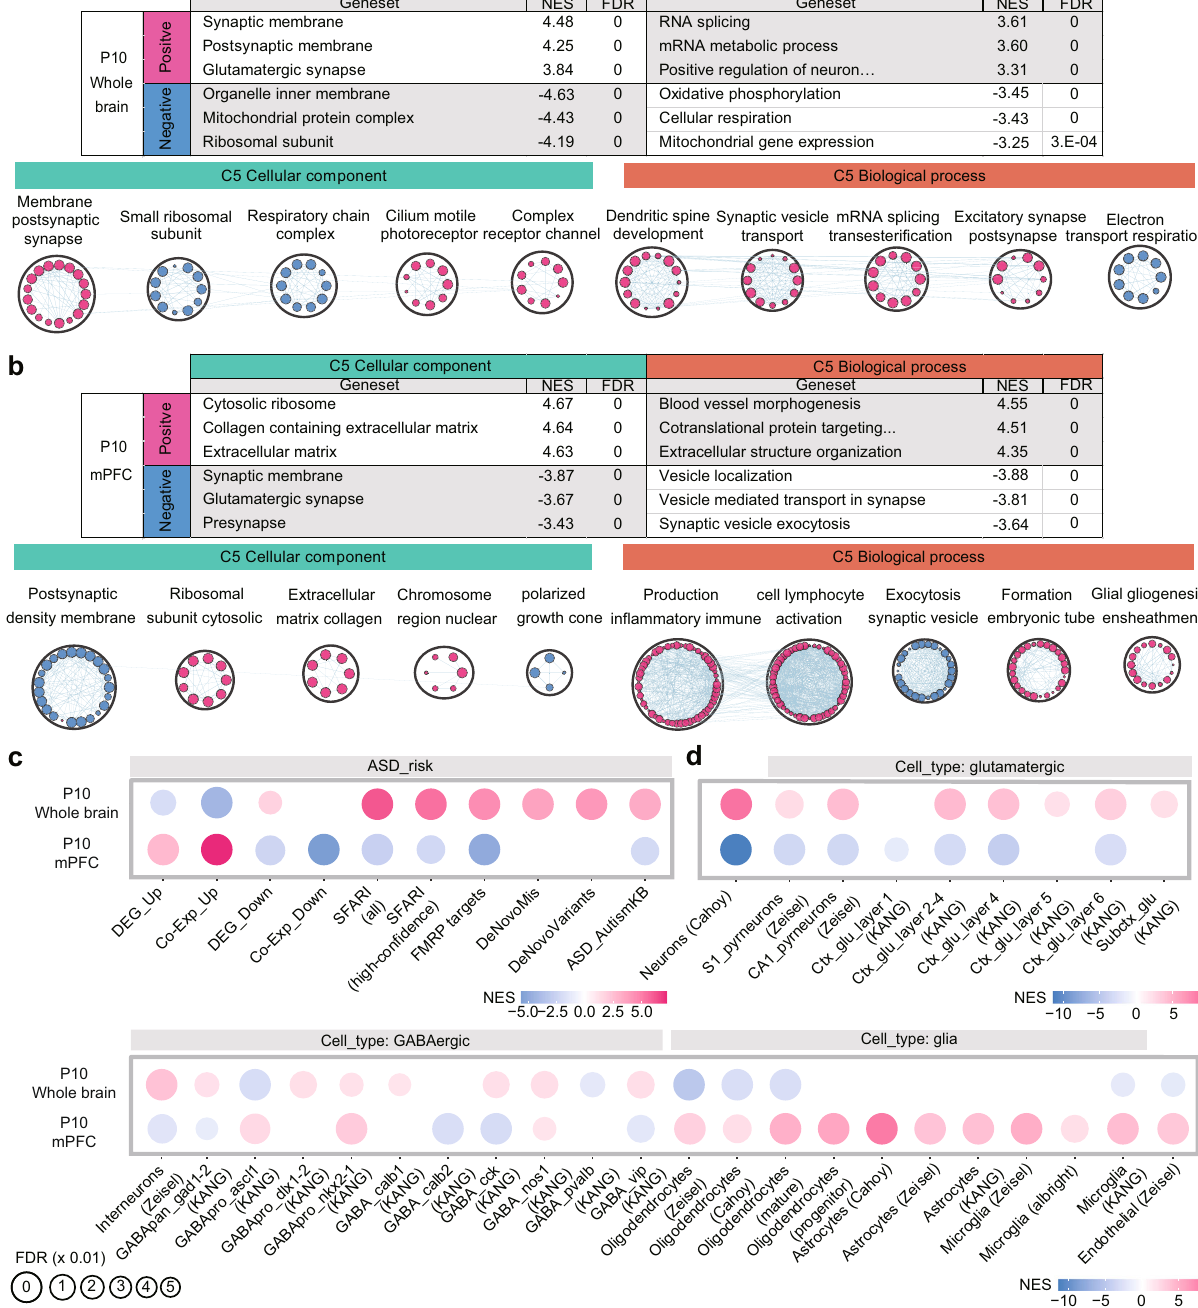
using Cytoscape EnrichmentMap (bottom). Only the top- fi ve clusters are shown to save space. NES normalized enrichment score; FDR false discovery rate. ( n =5 mice [WT and HT]). c GSEA of Arid1b/WT P10 whole-brain and mPFC transcripts for ASD-related/risk gene sets. ( n =5 mice [WT/HT]). d GSEA of Arid1b/WT P10 whole-brain and mPFC transcripts for cell-type-speci fi c gene sets. ( n =5 mice